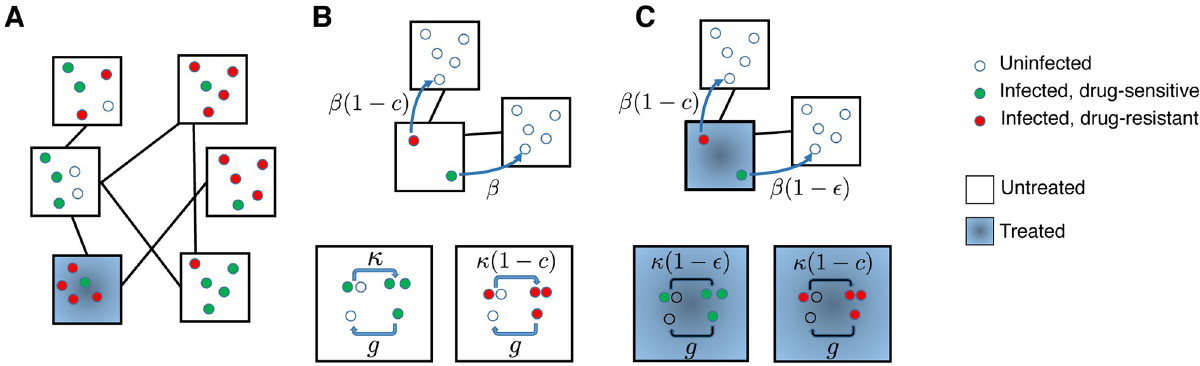
Fig 2. A structured population model for the spread of drug-resistant and drug-sensitive strains of an infection. A) An example population, divided into six equal subpopulations (“demes”, black squares) of five individuals (circles). Infection can spread within demes, and also between demes that are connected (black lines). Individuals are categorized based on their infection status (uninfected: open circle, infected with drug-sensitive strain: green circle, infected with drug-resistant strain: red circle). The deme where an individual is located may determine whether or not they will receive drug treatment (blue shading), or more generally, their probability of receiving treatment. B) Untreated deme: The wild-type strain (green) is transmitted at rate κ within a deme (bottom) and rate β between demes (top). Individuals infected with any strain recover with a rate g . The resistant strain (red) pays a cost c in its transmission rate with or without drug. C) Drug-treated deme: Transmission of the resistant strain is unaffected by whether the source individual is receiving treatment, but transmission of the wild-type strain (green) both within (bottom) and between (top) demes is reduced by a factor (1 − � ) if the source individual is treated, where � is the drug efficacy.